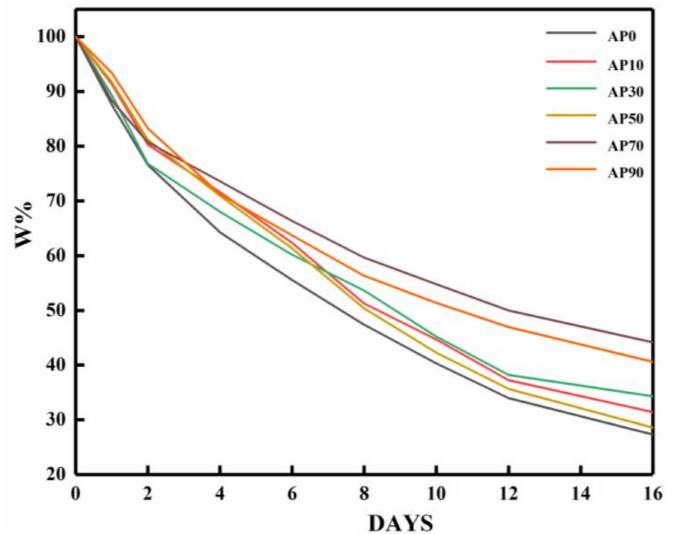
Figure 8. Water retention performance of gel